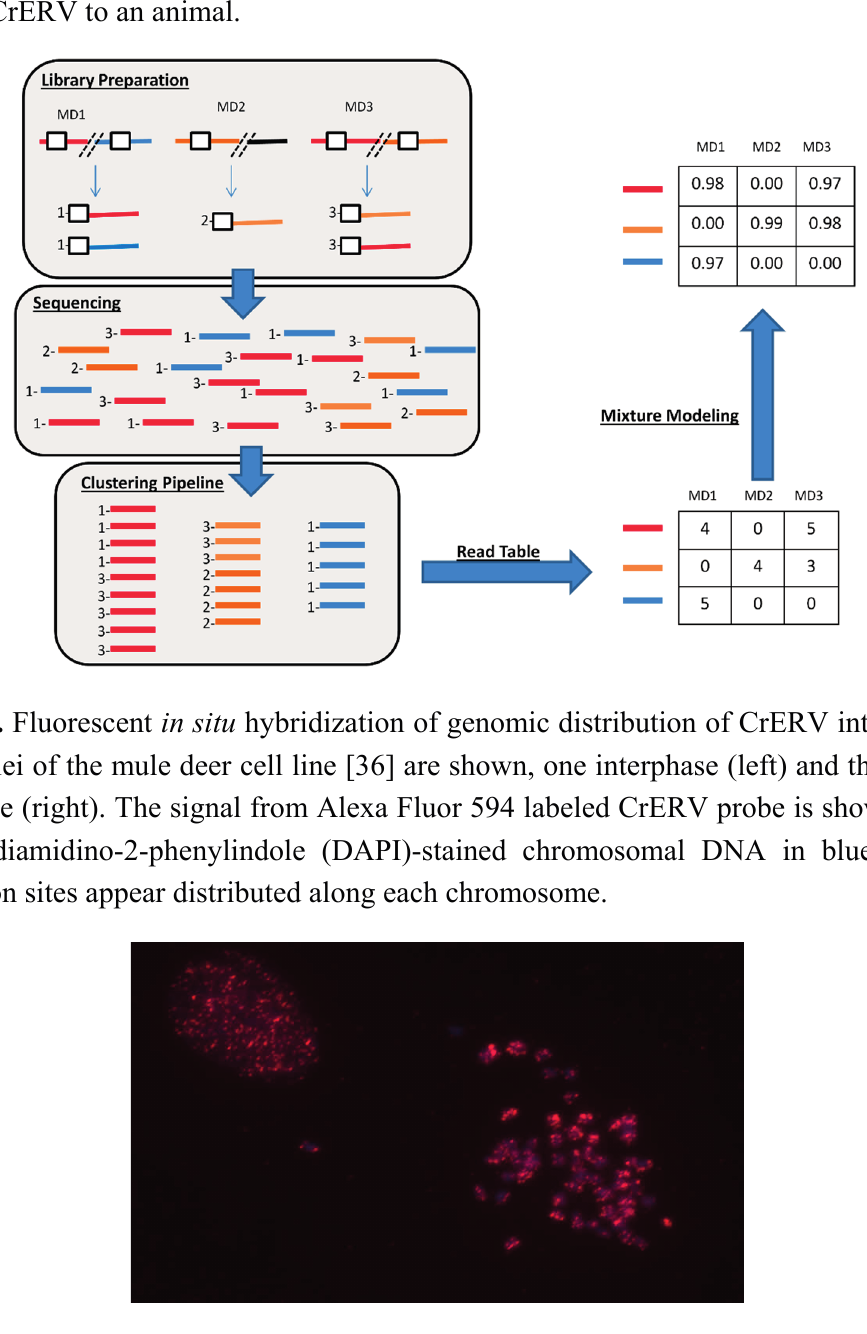
Figure 1. A schematic diagram of the workflow. For illustration purposes, three different CrERV integration sites, indicated by red, orange and blue colors, are shown from three different animals (marked MD1, 2 and 3). The CrERV-host junction fragment is enriched by PCR from the DNA of each animal and libraries are prepared, and then pooled and sequenced on the Ion Torrent platform. This results in a dataset of reads from all the CrERV-host junction fragments. These reads are clustered using the clustering pipeline to obtain three clusters representing the red, orange, and blue host genomic regions. Reads in a cluster are then separated into their animals of origin to obtain a read table. The read table is processed using mixture modeling to obtain the probability of correct assignment of each CrERV-host junction fragment clusters to each animal in the sample. In actual sequence data with higher read counts, low probabilities would reflect a spurious assignment of a read for a specific CrERV to an animal.